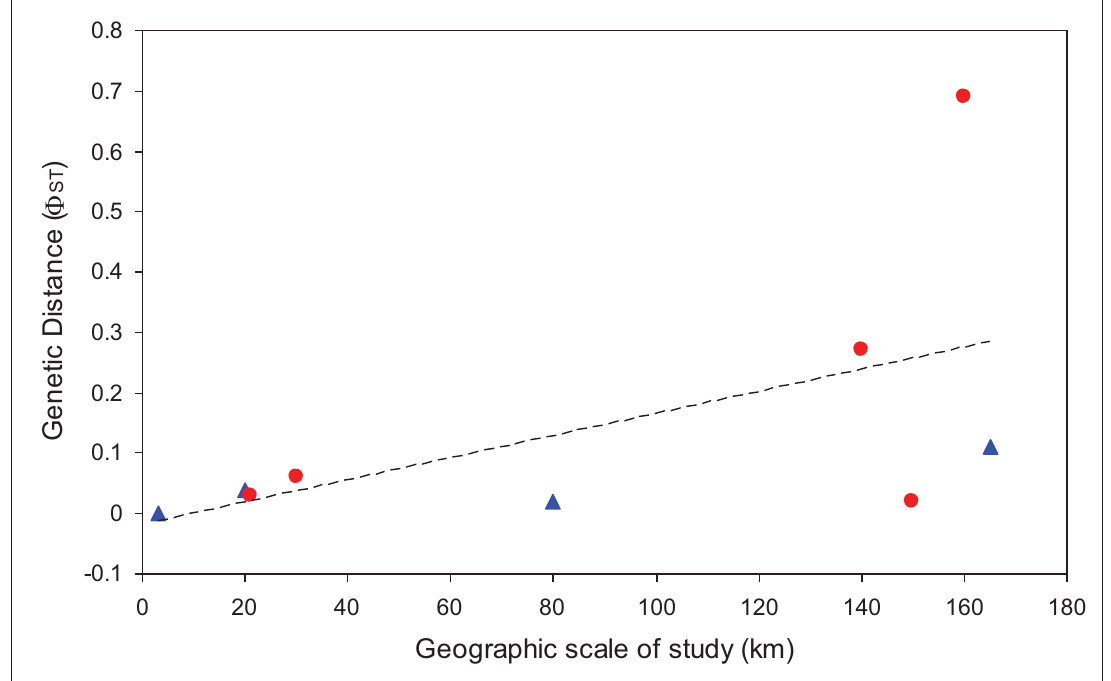
Figure 2. Scatter plot showing correlation between genetic distance and geographic scale of study for nine species of Ephemeroptera (red circles) and Trichoptera (blue